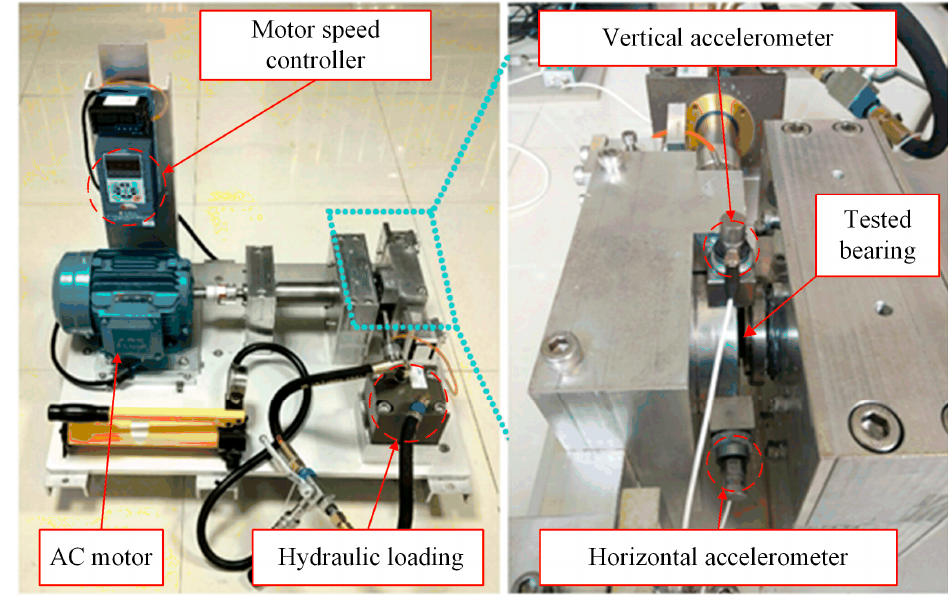
Figure 7. The test rig of the XJTU-SY. In this paper, the dataset collected under a rotational speed of 2250 rpm and a radial force of 11 kN is selected for experimental verification. Four different types of health states are considered for fault diagnosis, which are normal (Nor), inner race fault (IRF), outer race fault (ORF), and bearing cage fault (BCF). Since the dataset is a kind of full life cycle data, it is necessary to judge the initial occurred time of each fault from the whole data. Considering that the RMS-3 σ rule is a smooth and more accurate fault identification method [36], the RMS-3 σ rule is adopted to identify the early failure occurrence time point of each fault. The initial failure time of bearing 2–1, 2–2, and 2–3 (i.e., IRF, ORF, and BCF) are identified as 468, 52, and 334, respectively. That is, vibration signals after each initial failure point are used to construct data samples. The RMS-3 σ results and corresponding initial failure points are shown in Figure